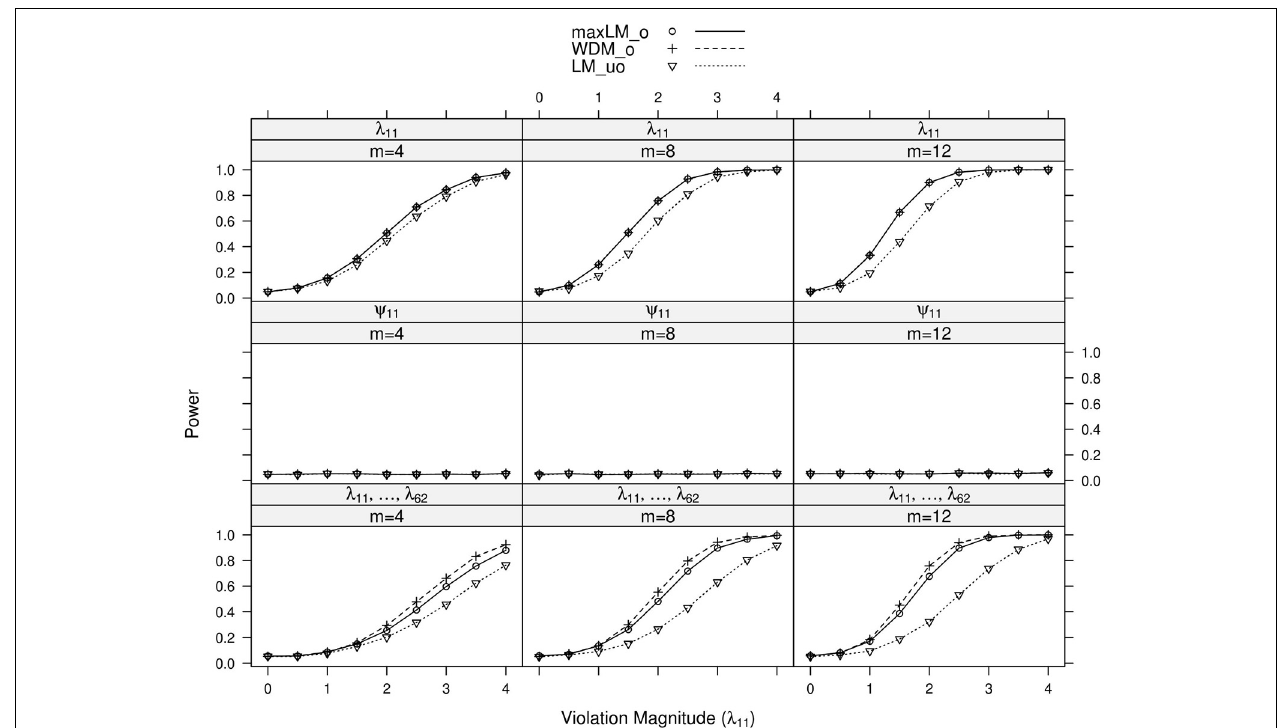
FIGURE 3 | Simulated power curves for max LM o , WDM o , and LM uo across three levels of the ordinal variable m and measurement invariance violations of 0–4 standard errors (scaled by